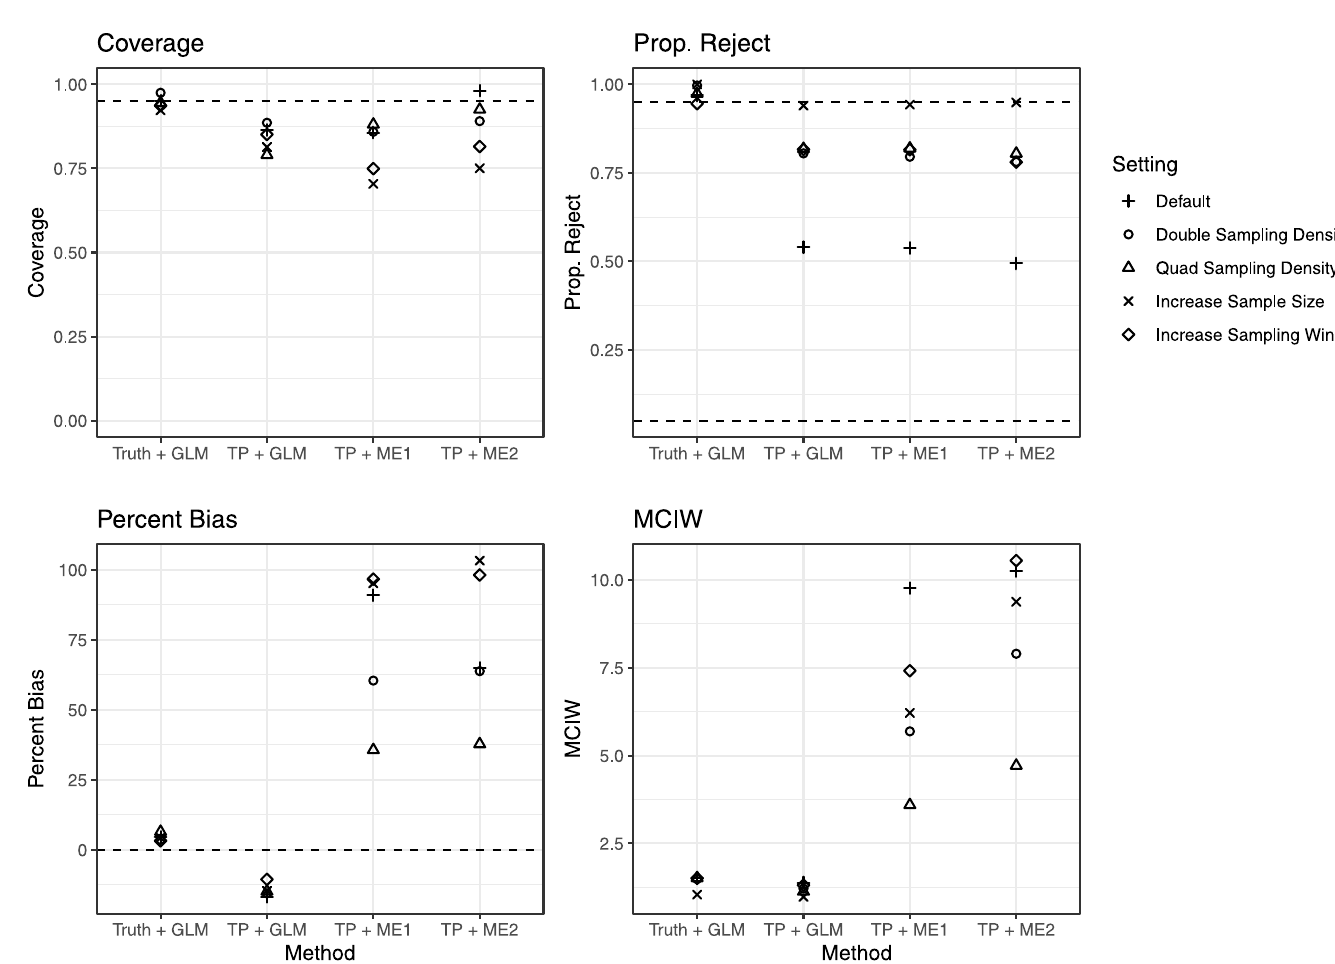
Fig 3. Operating characteristics of statistical pipelines in secondary simulation settings. See Fig 2 for x-axis and y-axis labels. The settings denote different simulation settings. For all simulations the probability of transmission given contact for cases living without HIV was 1.75 times as large as the probability of transmission given contact for cases living with HIV. Default refers to the simulation settings used in the primary simulation setting. In the Double Sampling Density setting percent of active cases sampled was doubled from 16% to 32%. In the Quad Sampling Density setting percent active cases sampled was quadrupled to 64%. In the Increase Sample Size setting the number of clusters sampled from was doubled from 50 to 100. In the Increase Sampling Window the sampling window was changed from the last three years of the simulation to the last seven